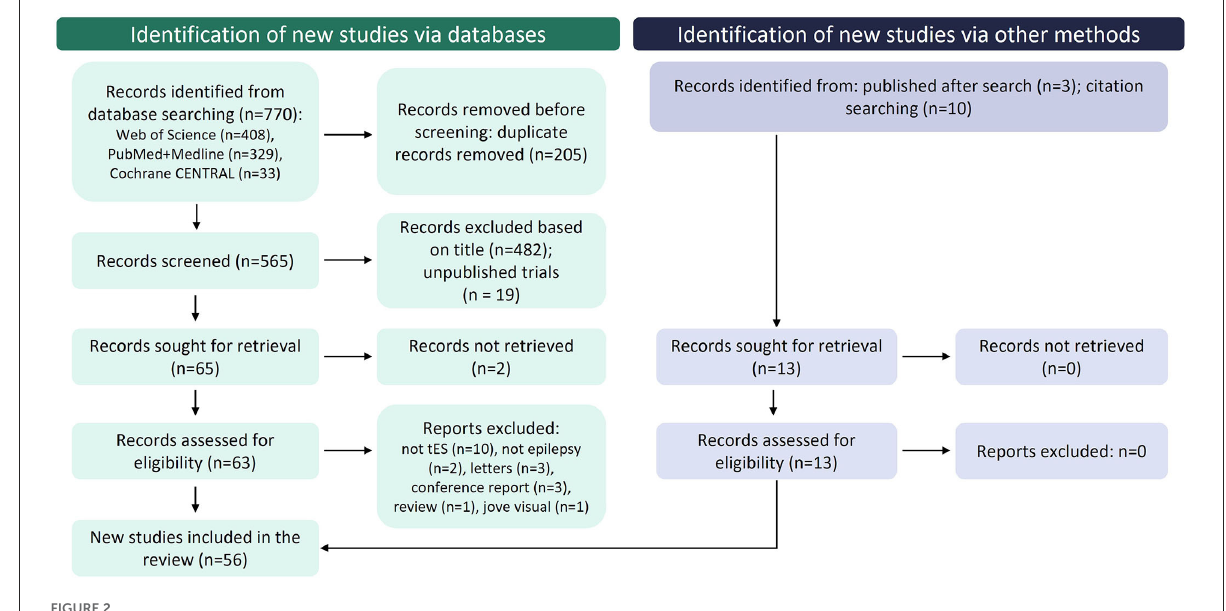
FIGURE2 Flowchart of PRISMA record selection